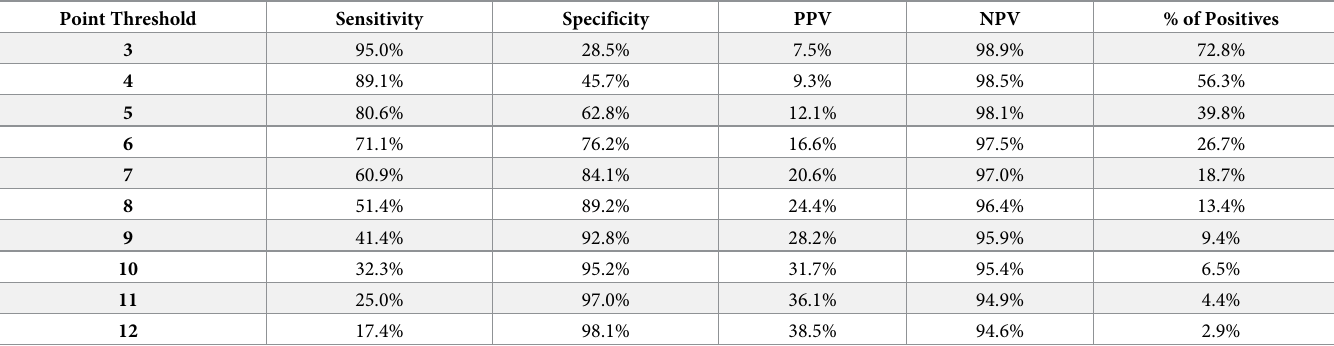
Table 7. Risk Score test characteristics across